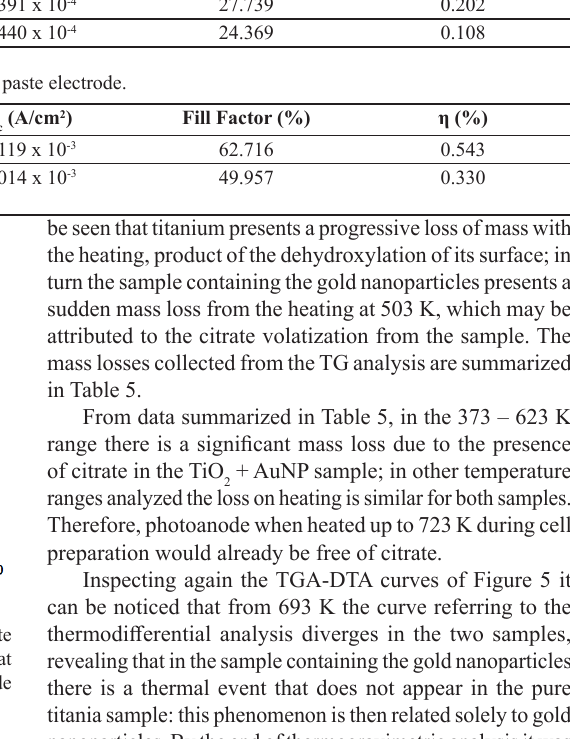
(0.005M) / 4-tert-butylpyridine; 2 2